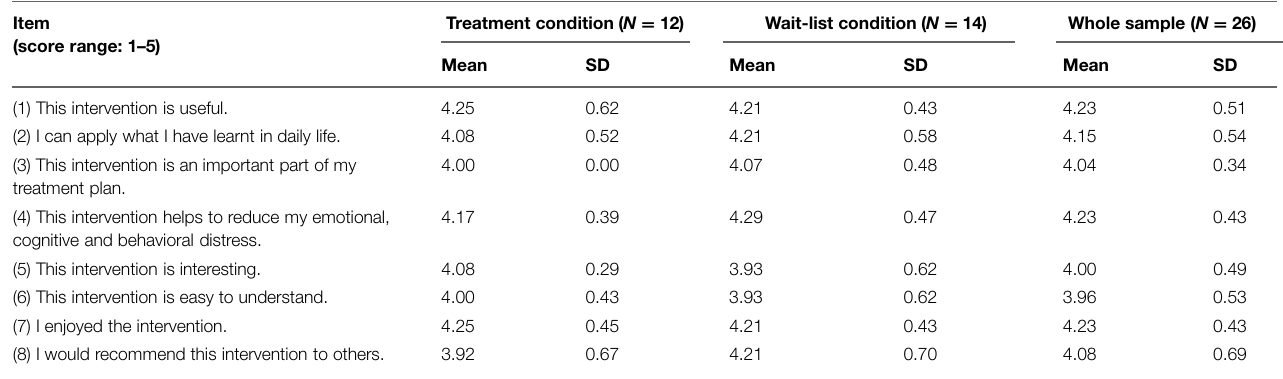
TABLE 2 | Ratings of subjective satisfaction towards Metacognitive Training for Delusions (MCTd). Item (score range: